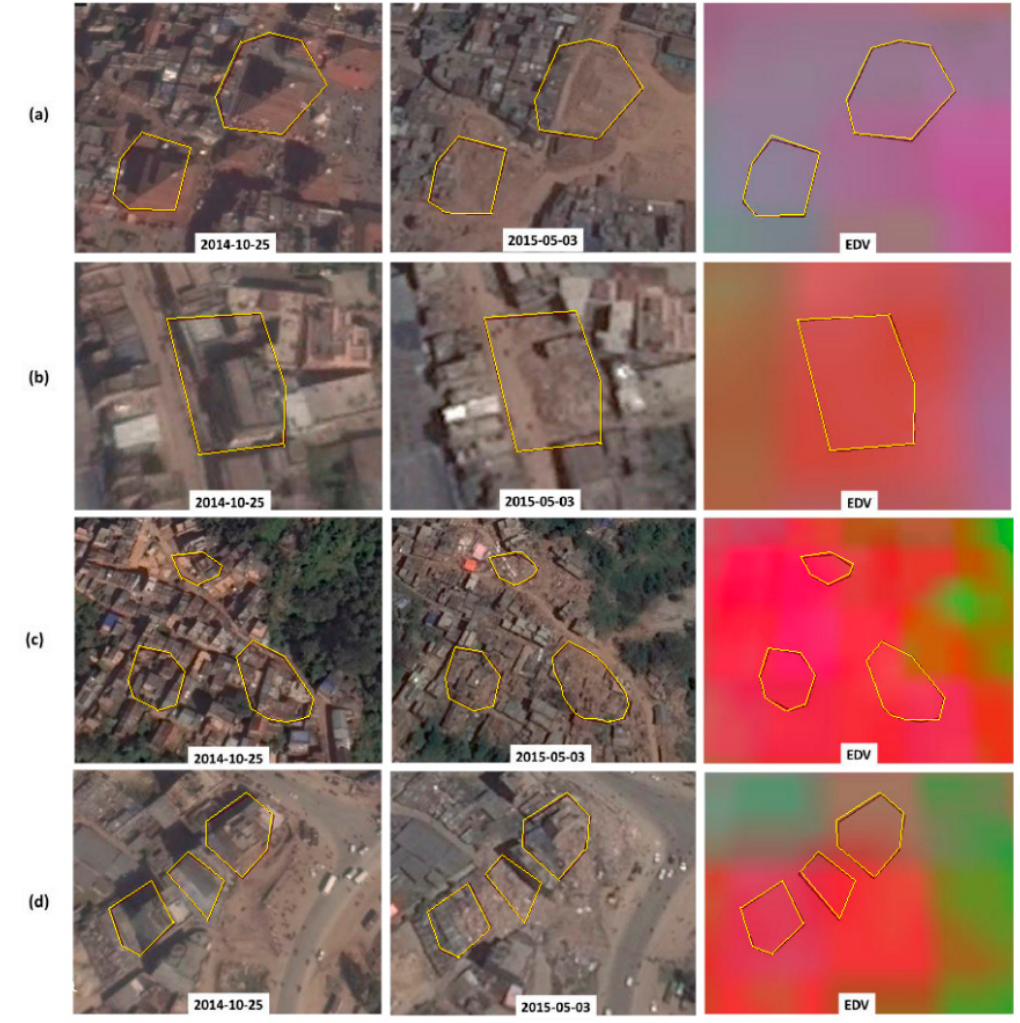
Figure 5. Performance of the EDV in different locations ( a – d ) that were highly damaged by the earthquake. The blocks of highly damaged (lethal) buildings are delineated by yellow polygons in each image. The left and middle columns show pre-seismic and post-seismic Google Earth images, whereas the right column shows the EDV image. The date of the Google Earth image is labeled in each image. The amount of redness in the EDV indicates severity of the building damage.